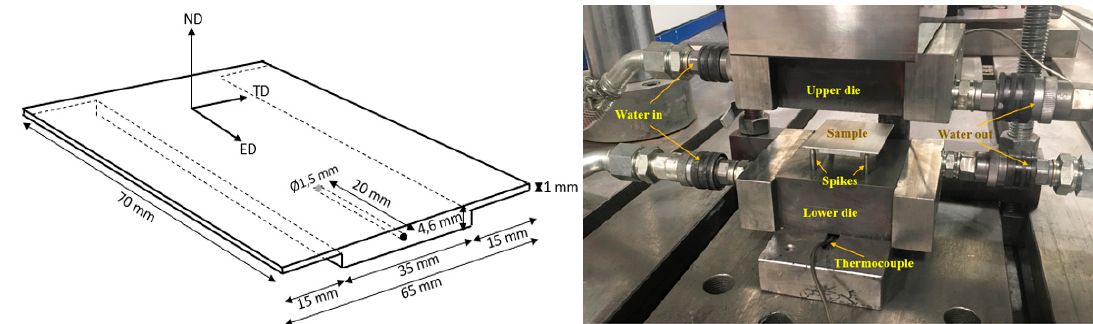
Figure 1. Sample dimensions and tool for deformation experiments. Table 1. Chemical composition of the extruded profile of AA6082.